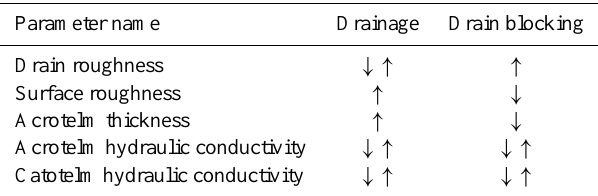
Table 1. Predicted direction of change of parameter values follow- ing drainage management